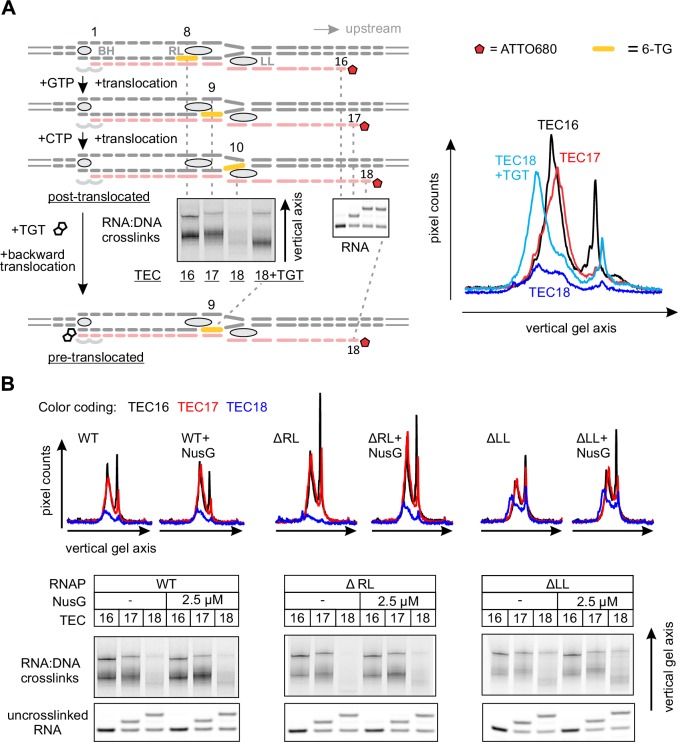
Probing the effects of NusG and deletions of the RNAP domains on the structure of the upstream fork junction by RNA:DNA photocrosslinking with 6-TG.(A) TECs containing 6-TG in the template DNA were walked by up to three nucleotides, supplemented with 5 µM TGT (where indicated) and illuminated with the UV light. (B) RNA:DNA crosslinking in TECs formed by the wild-type and altered RNAPs in the absence and presence of NusG. The gel panels were spliced from the same gel and the pixel counts were linearly scaled to span the full 8 bit grayscale range within each panel. The pixel intensity profiles for each gel lane are shown above the gels. The independent repeats are presented in Figure 5—figure supplement 2.